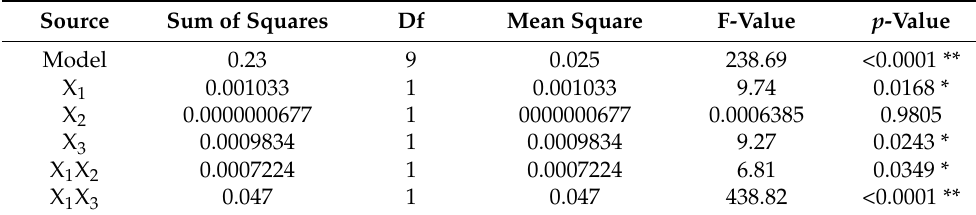
Table 2. Analysis of variance for response surface quadratic